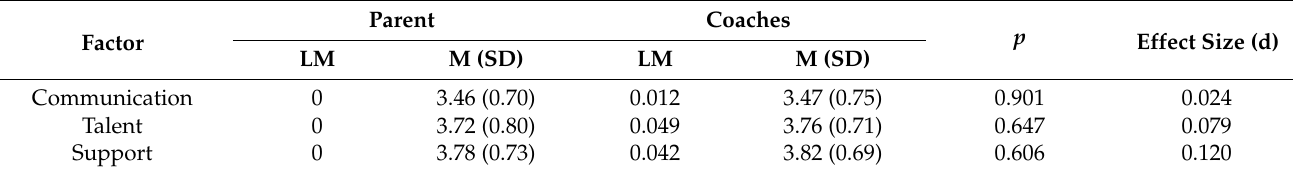
Table 5. Latent mean results of parent–coach